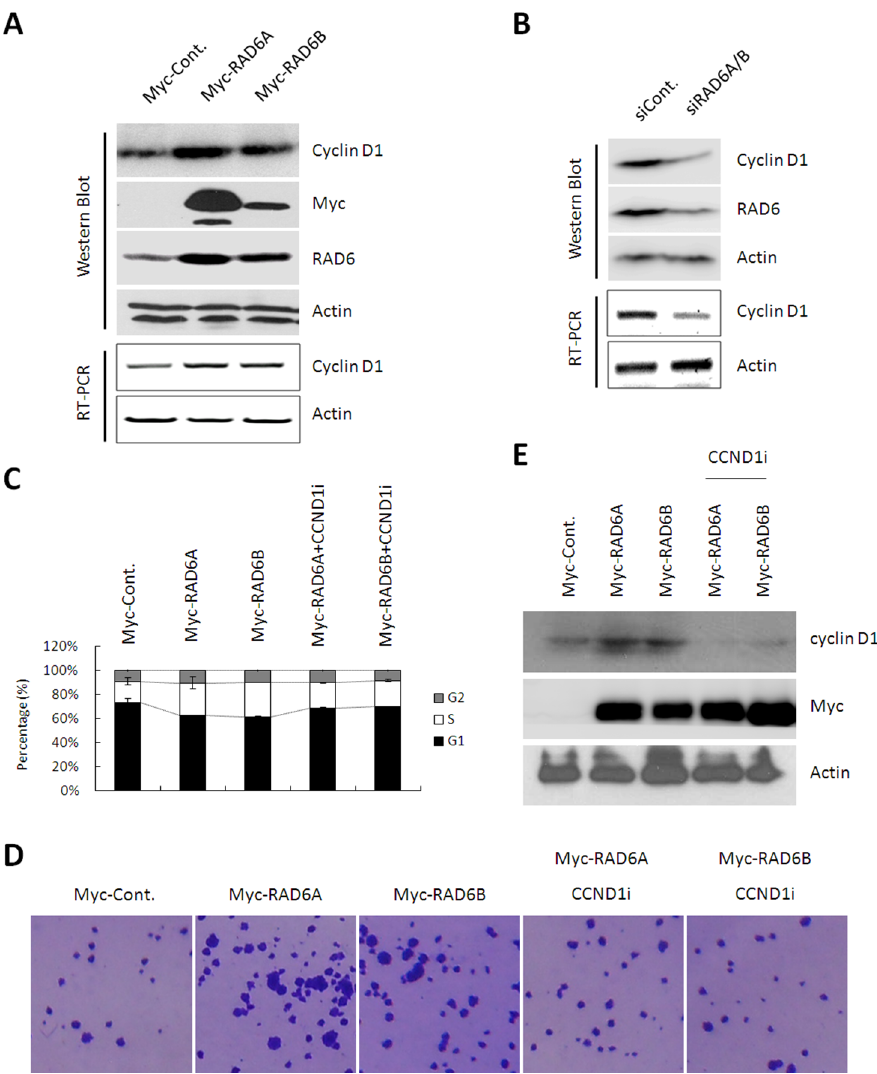
Figure 3. RAD6 regulates the expression of cyclin D1 in both the mRNA and protein level. ( A ) HL-7702 cells transfected with an empty control or Myc-RAD6 expressing plasmids were lysed and subjected to RT-PCR and western blot assays. ( B ) HL-7702 cells transfected with control or RAD6 siRNAs were lysed and subjected to RT-PCR and western blot assays. ( C ) HL-7702 cells transfected with an empty control and Myc-RAD6 plasmids together with or without CCND1 siRNA were harvested and stained with PI, and then cells were subjected to cell cycle assay. The quantification of the cell cycle assay is shown. ( D ) Soft agar colony formation assays were performed using control, or RAD6 overexpressing, or RAD6 overexpressing together with CCND1 knocking down HL-7702 cells. ( E ) HL-7702 cells used in the above assays were lysed and subjected to western blot analyses with antibodies against CCND1, Myc-tag and Actin as indicated.